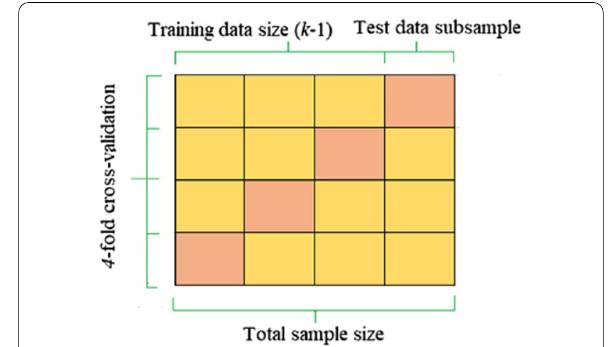
Fig. 4 Illustration of k-fold